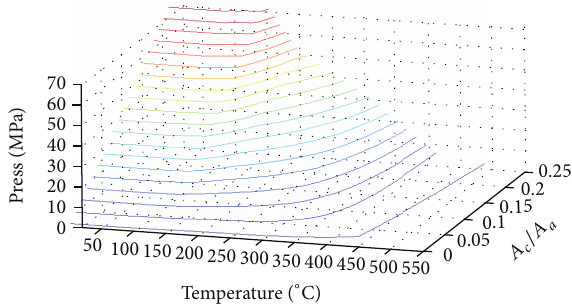
Figure 16: Relation between temperature, contact area, and normal